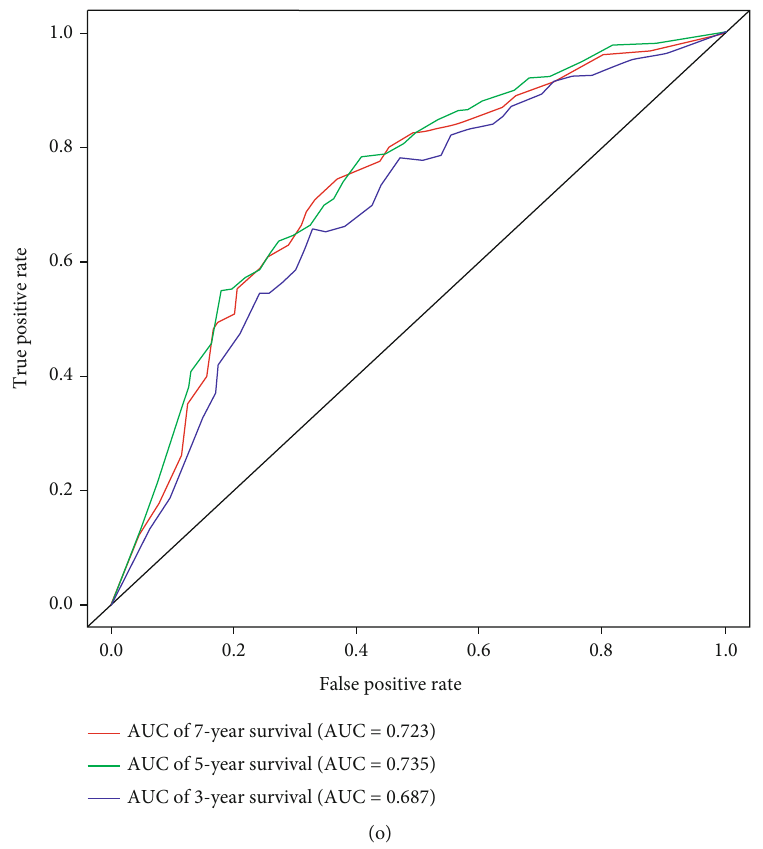
Figure 4: Prognostic analysis of the fi ve-lncRNA signature in three sets. (a – c) The curves of risk score in the training set, the testing set, and the whole set. The dotted line represents the cuto ff score and divides the patients into the low-risk and high-risk groups. (d – e) Survival status of the patients in the training set, the testing set, and the whole set. The orange dots represent dead patients while the green dots represent alive patients. More dead patients correspond to the higher risk score. (g – i) Boxplots of the expression pro fi les of the fi ve PIDElncRNAs in the training set, the testing set, and the whole set. (j – l) Kaplan-Meier survival analysis of the fi ve-lncRNA signature in the training set, the testing set, and the whole set. (m – o) Time-dependent ROC curves of the fi ve-lncRNA signature in the training set, the testing set, and the whole set. PIDElncRNAs: prognostic immune-related di ff erentially expressed lncRNAs; ROC: receiver operating